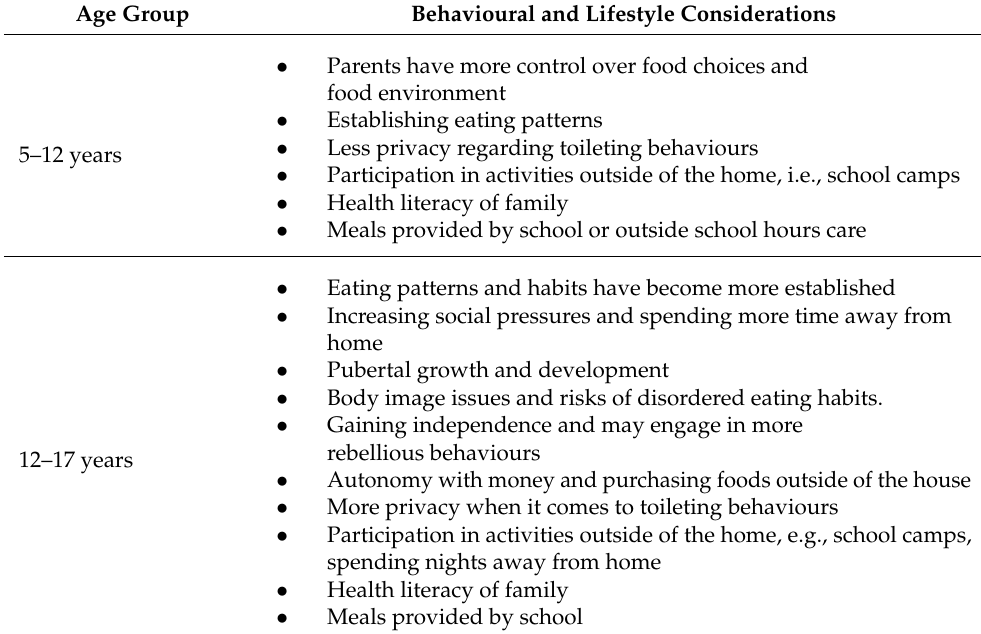
Table 3. Behavioural and lifestyle considerations during consultations with paediatric gastrointestinal